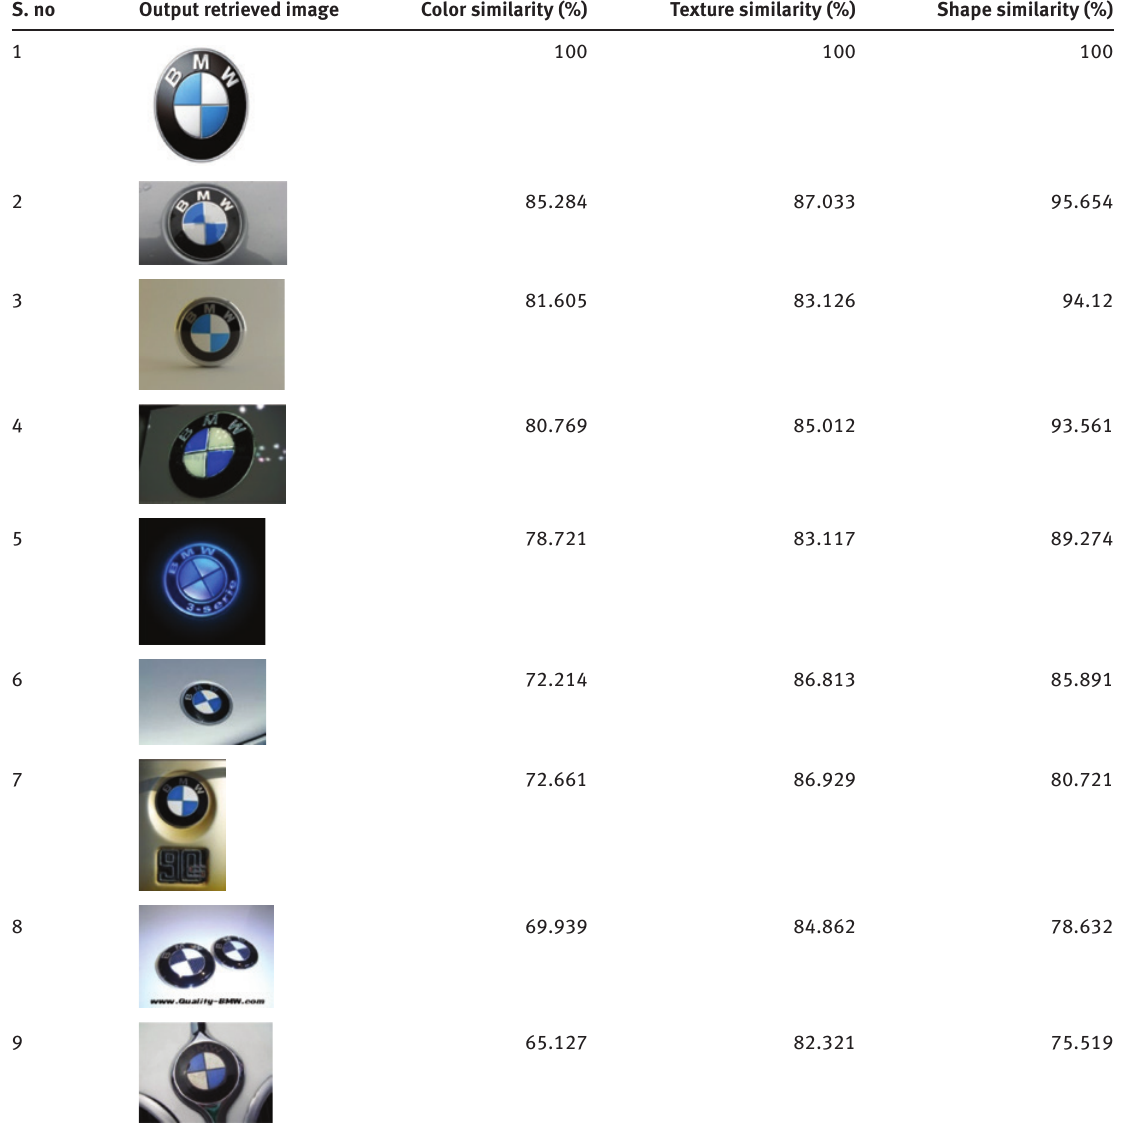
Table 6: Color, Texture, and Shape Similarity with Respect to the Sample Query Image. S.